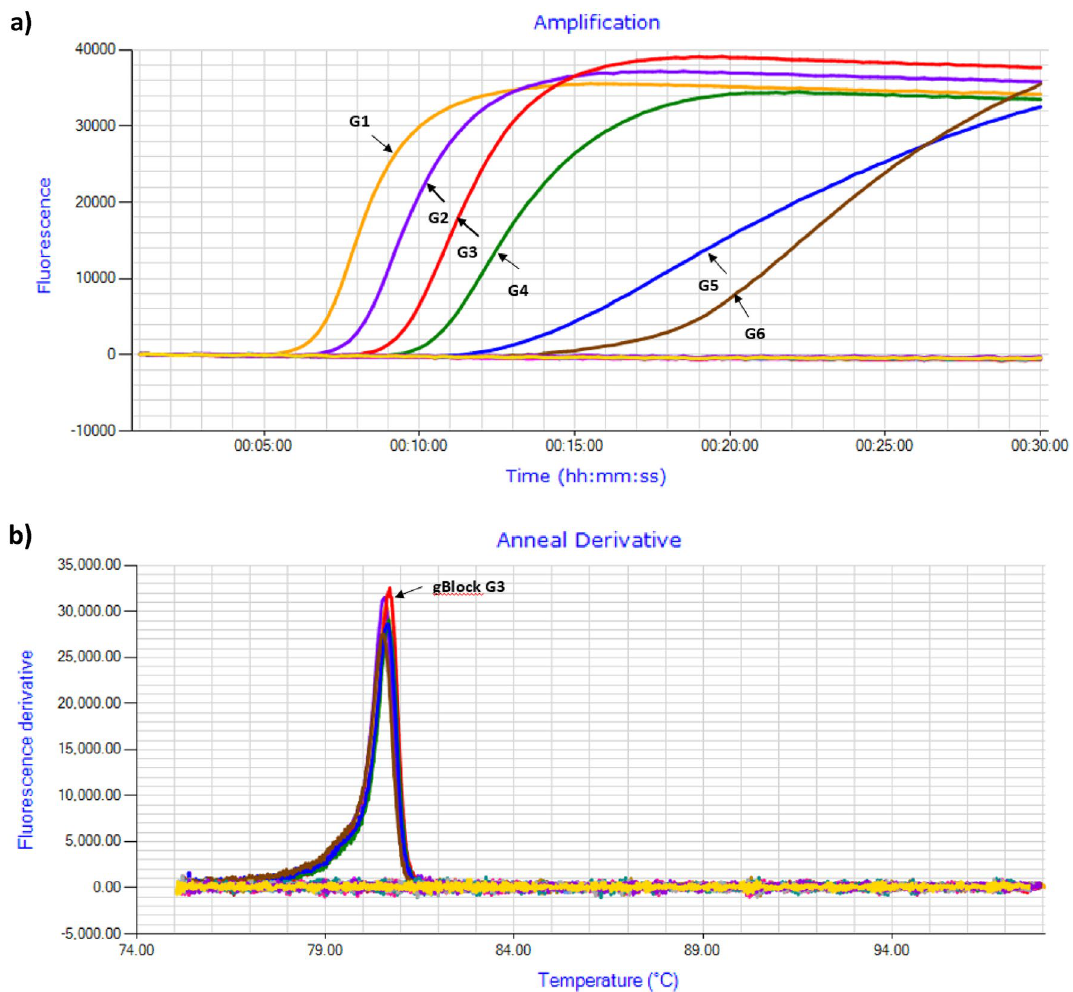
Figure 6. Performance of C. brevis gBlock dsDNA amplicons. ( a ) Amplification profile with DNA templates ranging from 10 to 0.00010 ng/µl at ten-fold dilution. ( b ) Annealing derivative of LAMP amplicons with an anneal derivatives of 80.5–80.7